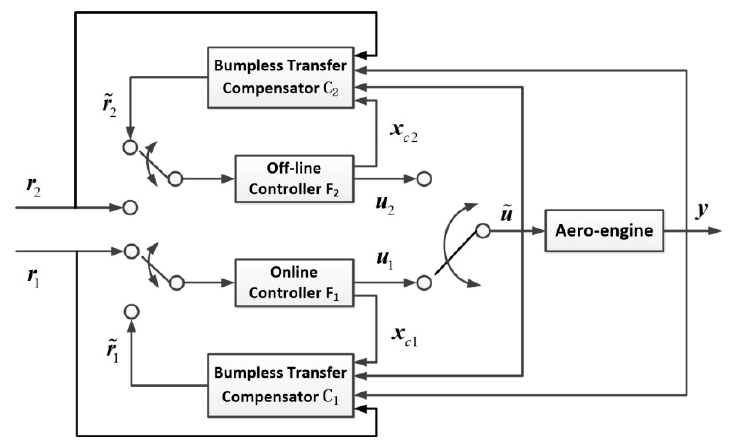
Figure 6. Schematic diagram of bumpless transfer method.